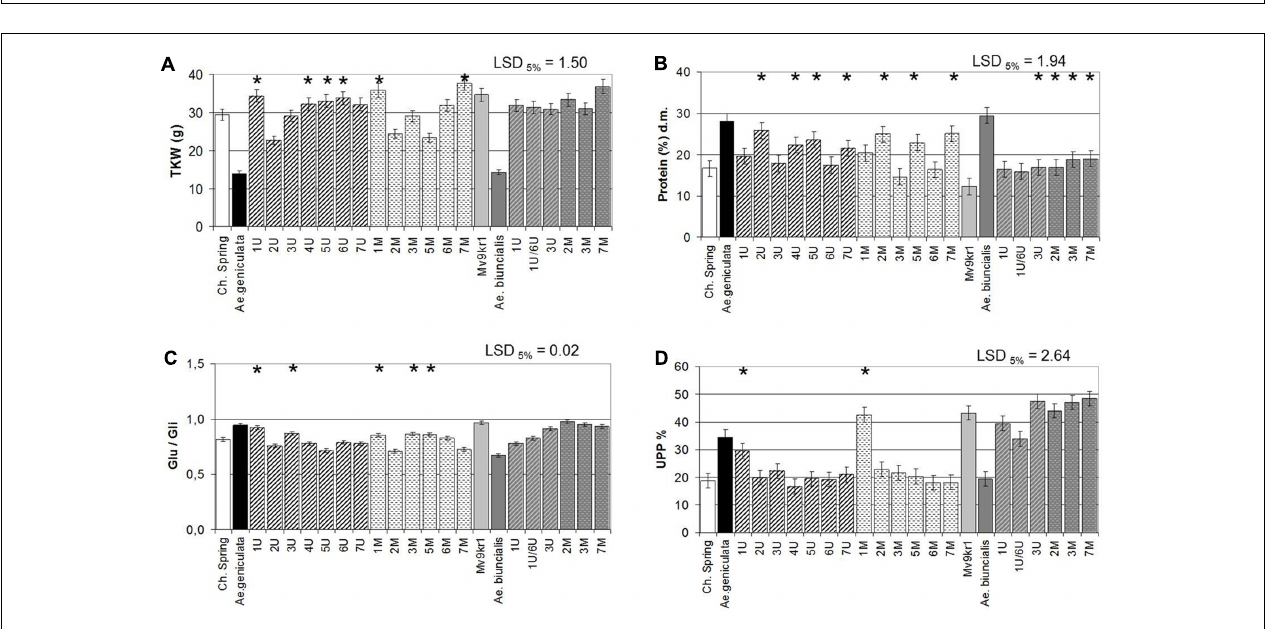
FIGURE 1 | Thousand kernel weight and compositional properties of five Aegilops biuncialis and five Aegilops geniculata genebank accessions. (A) Thousand kernel weight, (B) protein and β -glucan content, (C) TOT-pentosan and WE-pentosan content. LSD, least significant difference; TOT, total; WE, water extractable.